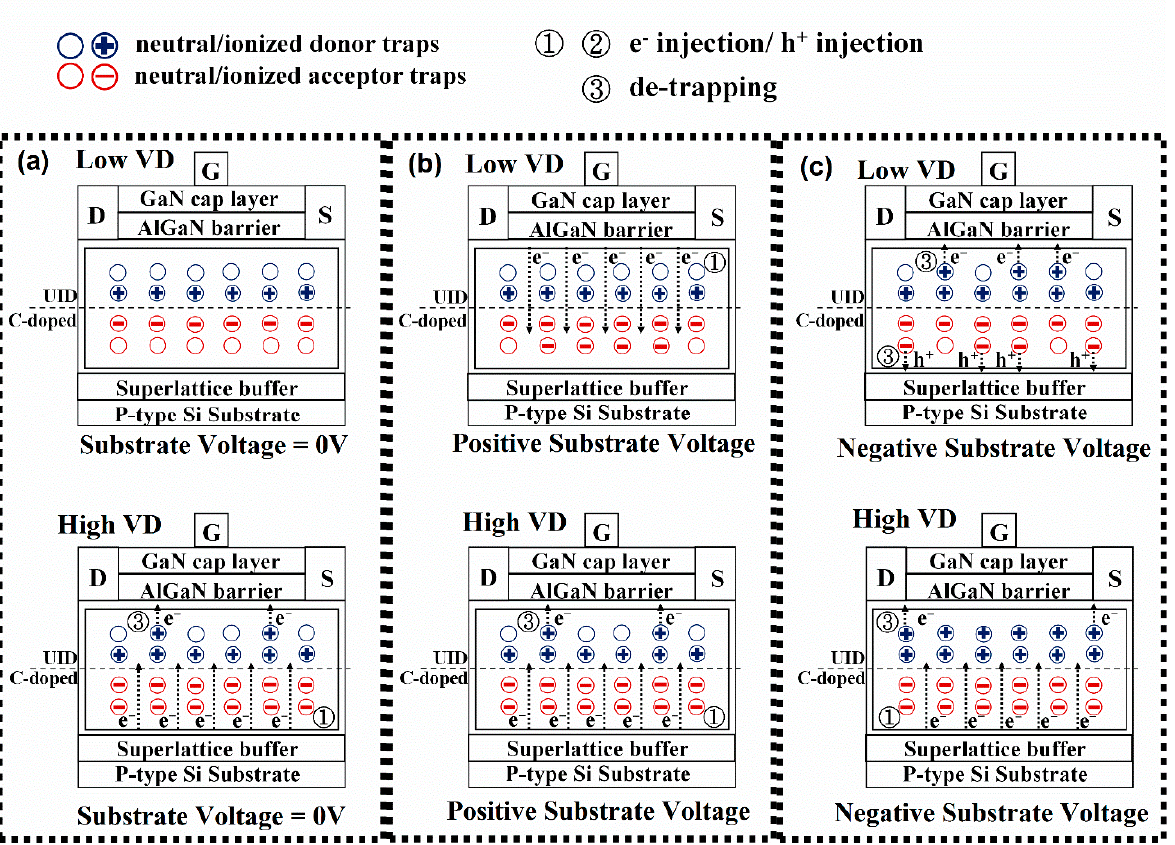
Figure 2. ( a ) Without V SUB : the traps charging/discharging in the buffer while applying the low or high drain voltage (V D ). ( b ) With positive V SUB : the traps charging/discharging in the buffer while applying the low or high V D . ( c ) With negative V SUB : the traps charging/discharging in the buffer while applying the low or high V D .